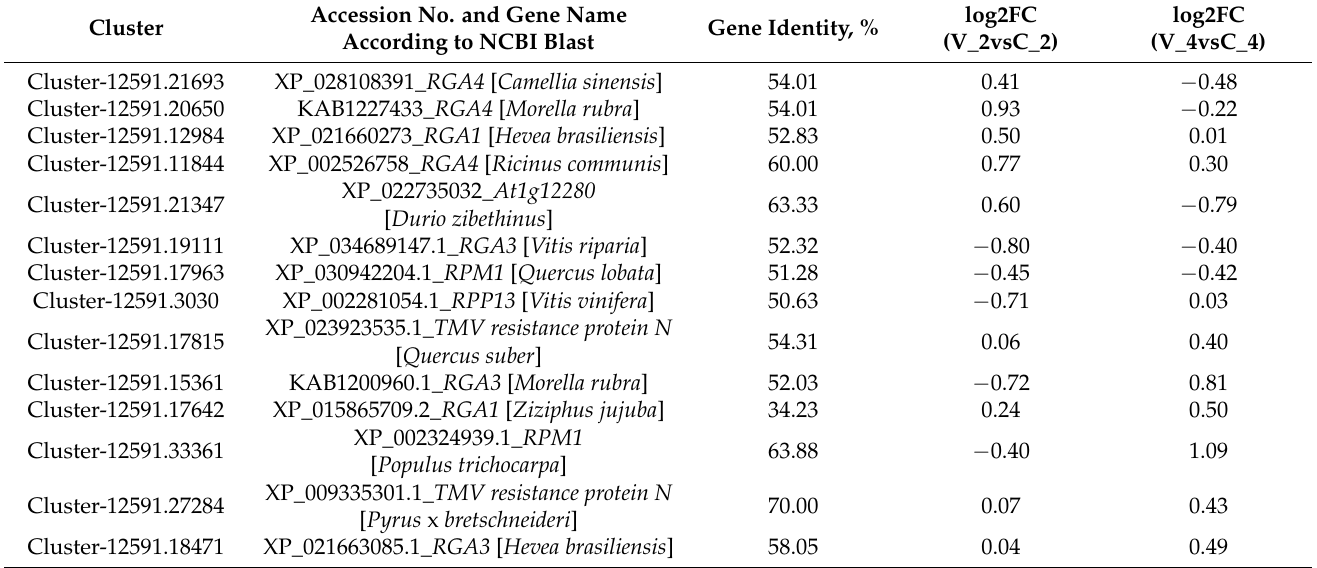
Table 1. Identification and log2FC expression values of significantly expressed R. nigrum genes.